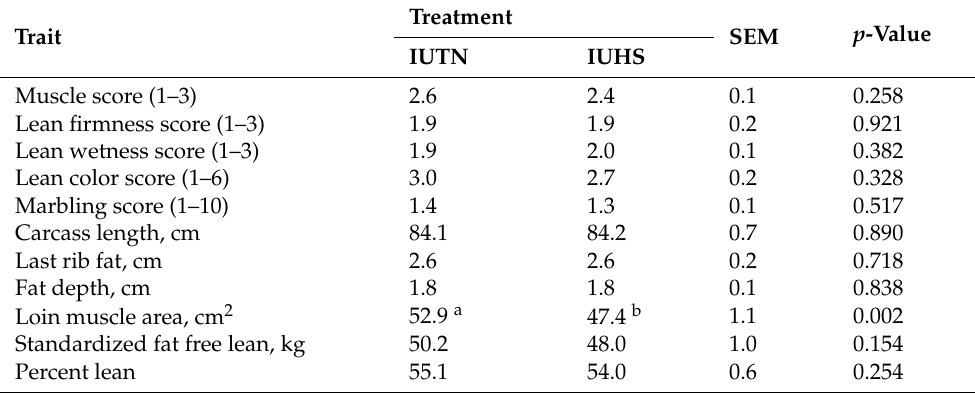
Table 2. Main effect of IUHS treatment on carcass attributes of gilts ( n =